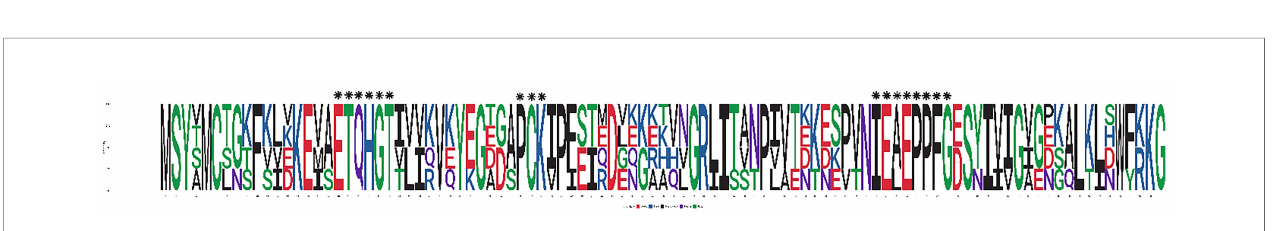
FIGURE 1 | Dengue phylogenetic tree. Neighbor-joining phylogenetic tree based on 5 different isolates of dengue from serotypes DENV-1, DENV-2, DENV-3, and DENV-4. Each taxon indicates a single dengue genome and is labeled with the serotype and isolate name. Genomes were collected from NCBI Nucleotide database. Tree was built with neighbor-joining clustering method using Jalview (30) and visualized with iTOL (https://itol.embl.de/). Source of sequences: for DENV-1 Genbank accession numbers KY057373.1, JQ675358.1, MH891771.1, KY672944.1, MK506262.1, for DENV-2 Genbank accession numbers KX702403.1, FM210244.2, FM210246.2, FM210245.2, FM210242.2, for DENV-3 Genbank accession numbers MF370226.1, KR296744.1, MK506265.1, MH823209.1, KY863456.1, for DENV-4 Genbank accession numbers MH382789.1, MH823210.1, MG601754.1, MH891769.1, MK506266.1.